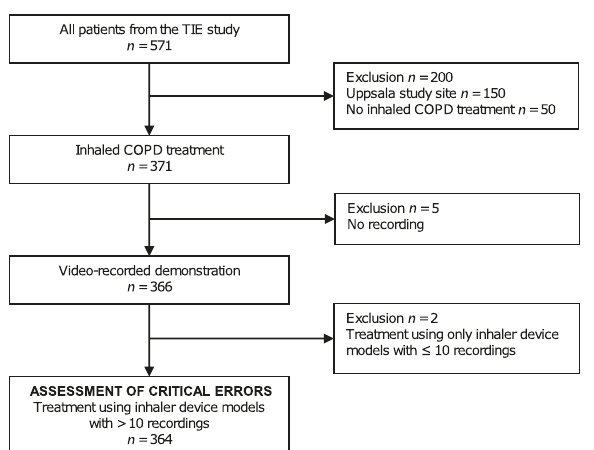
Fig. 1 Flowchart of patients included in and excluded from the assessment of critical errors in inhaler technique. COPD chronic obstructive pulmonary disease, TIE tools for identifying